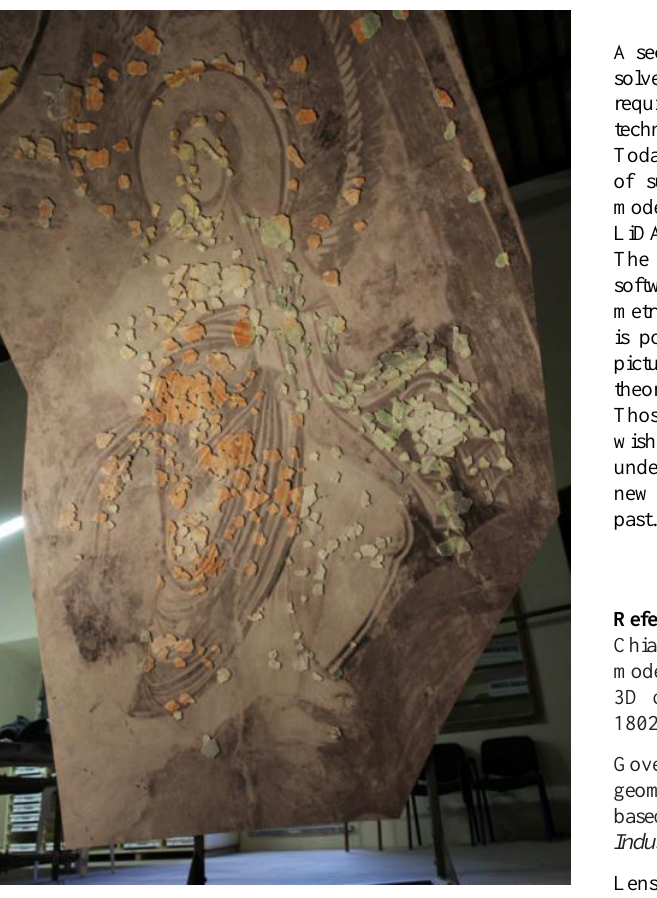
Figure 20. Thecomplete final 1:1 scale 3D model of a significant part of the old dome ready to be presented to the visitors. (Courtesy of ISCR and Werner Matthias Schmid)